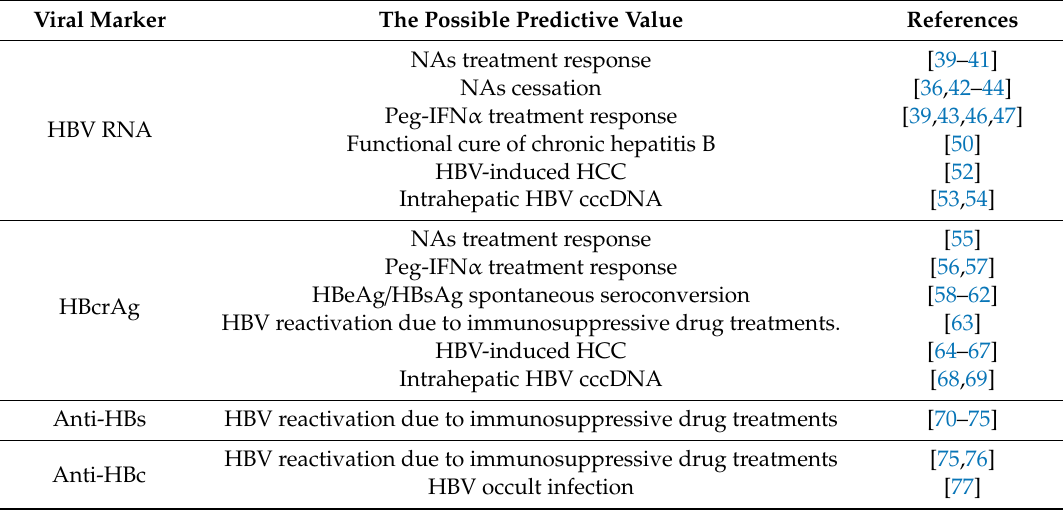
Table 1. Potential clinical application of novel viral biomarkers in chronic hepatitis B infection. Viral